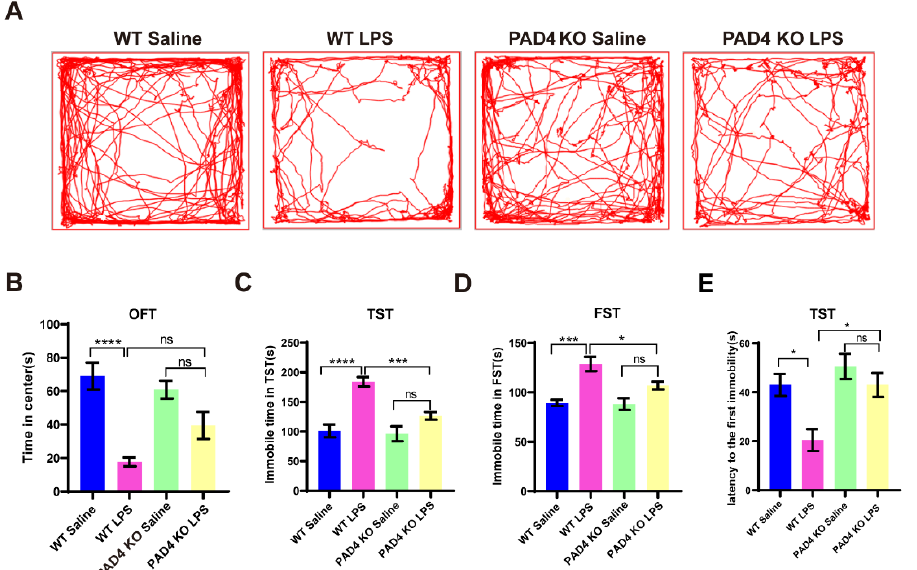
Figure 2. PAD4 knockout alleviated depression-like behaviors in LPS-treated mice. ( A ) Total distance traveled and line crossing in the open field. ( B ) Total time spent in the center of the open field. ( C ) Immobile time during the TST. ( D ) Immobile time during the FST. ( E ) The latency to the first immobility in TST. Data were expressed mean ± SEM ( n = 9). * p < 0.05, *** p < 0.001, **** p < 0.0001. WT Saline: n = 7; WT LPS: n = 8; PAD4 KO Saline: n = 7; PAD4 KO LPS: n = 9 .